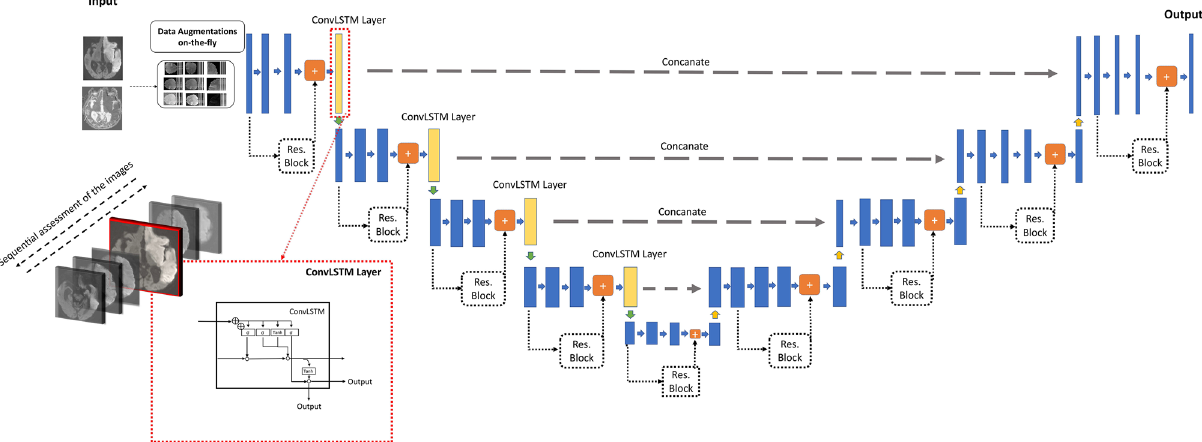
Figure 2. Residual two-dimensional convolutional long short-term memory (ConvLSTM) U-net. The stack of high b-value diffusion-weighted images and corresponding apparent diffusion coefficient maps are fed into the network per-patient. Two important modifications are made to the 2D U-net. First, residual layers are utilized for each convolutional block, which allows unimpeded propagation of information throughout the network and mitigates the vanishing gradient problem. Second, bi-directional ConvLSTM layers are implemented on top of each convolutional block of the encoder network to allow communication of the feature maps. Consequently, it enables the network to consider all of the slices of an examination before delineating an ischemic lesion’s borders. Therefore, we suggest that this architecture, to some extent, mimics how radiologists assess images, which involves sequential assessment of all slices of an examination before making the final diagnosis or, in this context, performing segmentation.